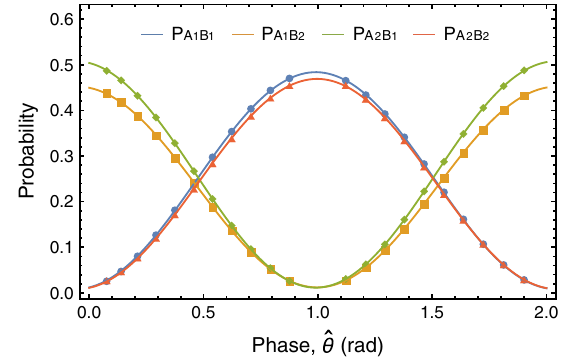
FIG. 6. Experimental interference fringes of four detection events versus different phase shifts for a distance of 10